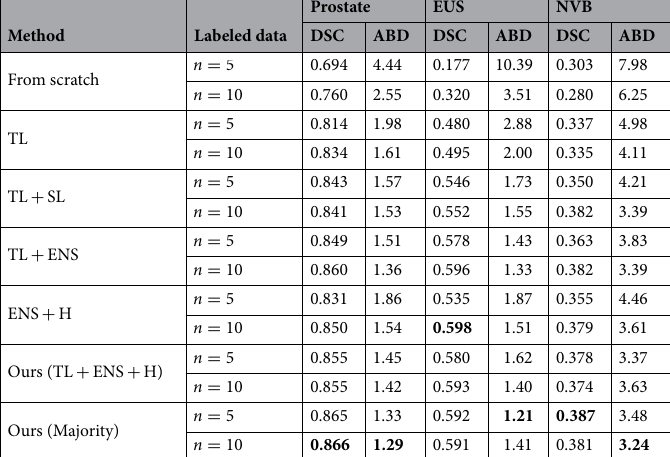
Table 2. Evaluation results for the source model, training from scratch and the proposed DA method with its ablation study on Prostate-3T test data. Results are given as Dice Coefficient (DSC) and average boundary distance (ABD in mm). Majority (TL + ENS + H) denotes the approach, where the ensemble of models from our TL + ENS + H is used to generate a majority vote as outcome. Best results are marked